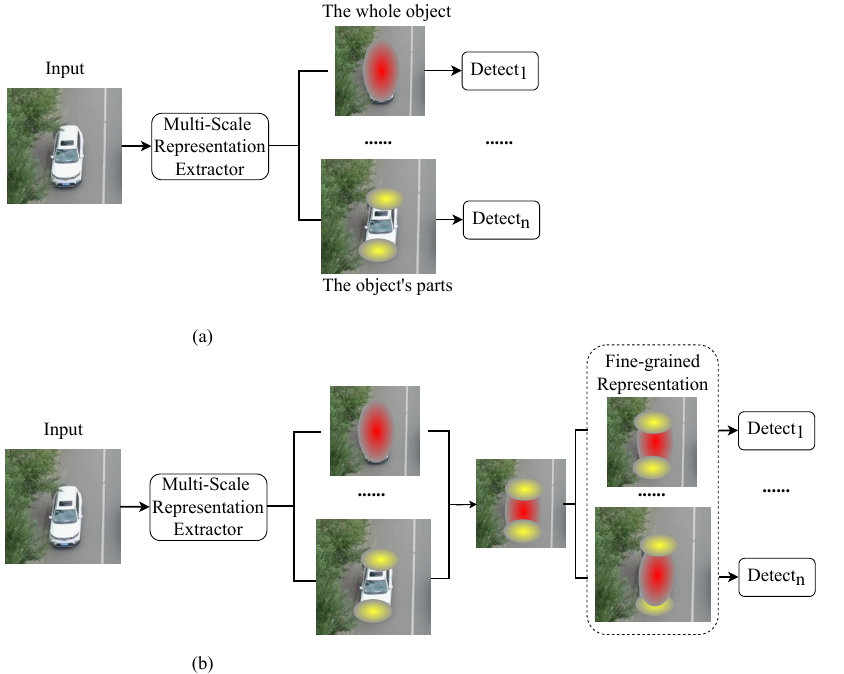
Figure 1. Comparisons between the conventional coarse-grained representation ( a ) and our fine- grained representation ( b ).